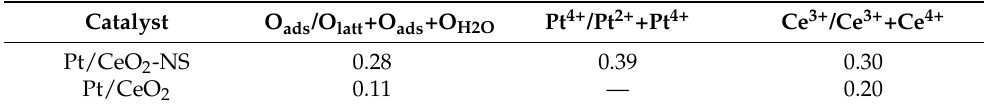
Table 3. Ratios of O ads /O latt +O ads +O H2O , Pt 4+ /Pt 2+ +Pt 4+ , and Ce 3+ /Ce 3+ +Ce 4+ of Pt/CeO 2 -NS and Pt/CeO 2 measured by